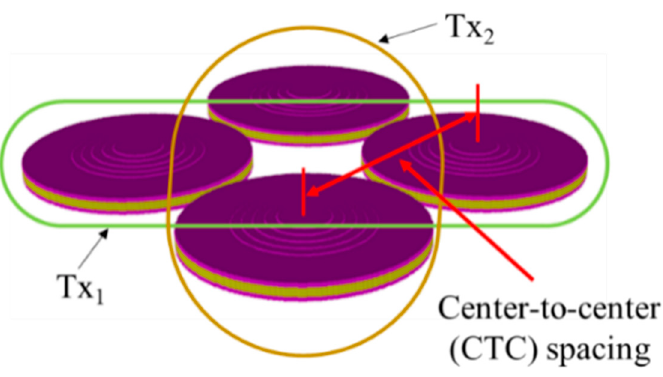
Figure 3. A 3D FEA model of the 2 × 2 cymbal